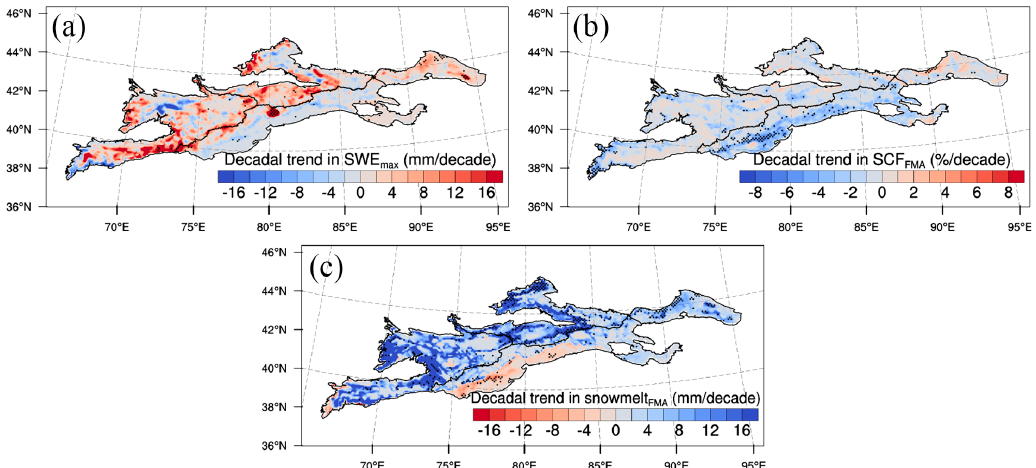
Figure 4. Trend distribution of the mean snow metrics: SWE max ( a ), SCF FMA ( b ), and ( c ) Snowmelt FMA from 1983 to 2015. The black dots in Figure 4 indicate the trend at a 0.05 significant level.